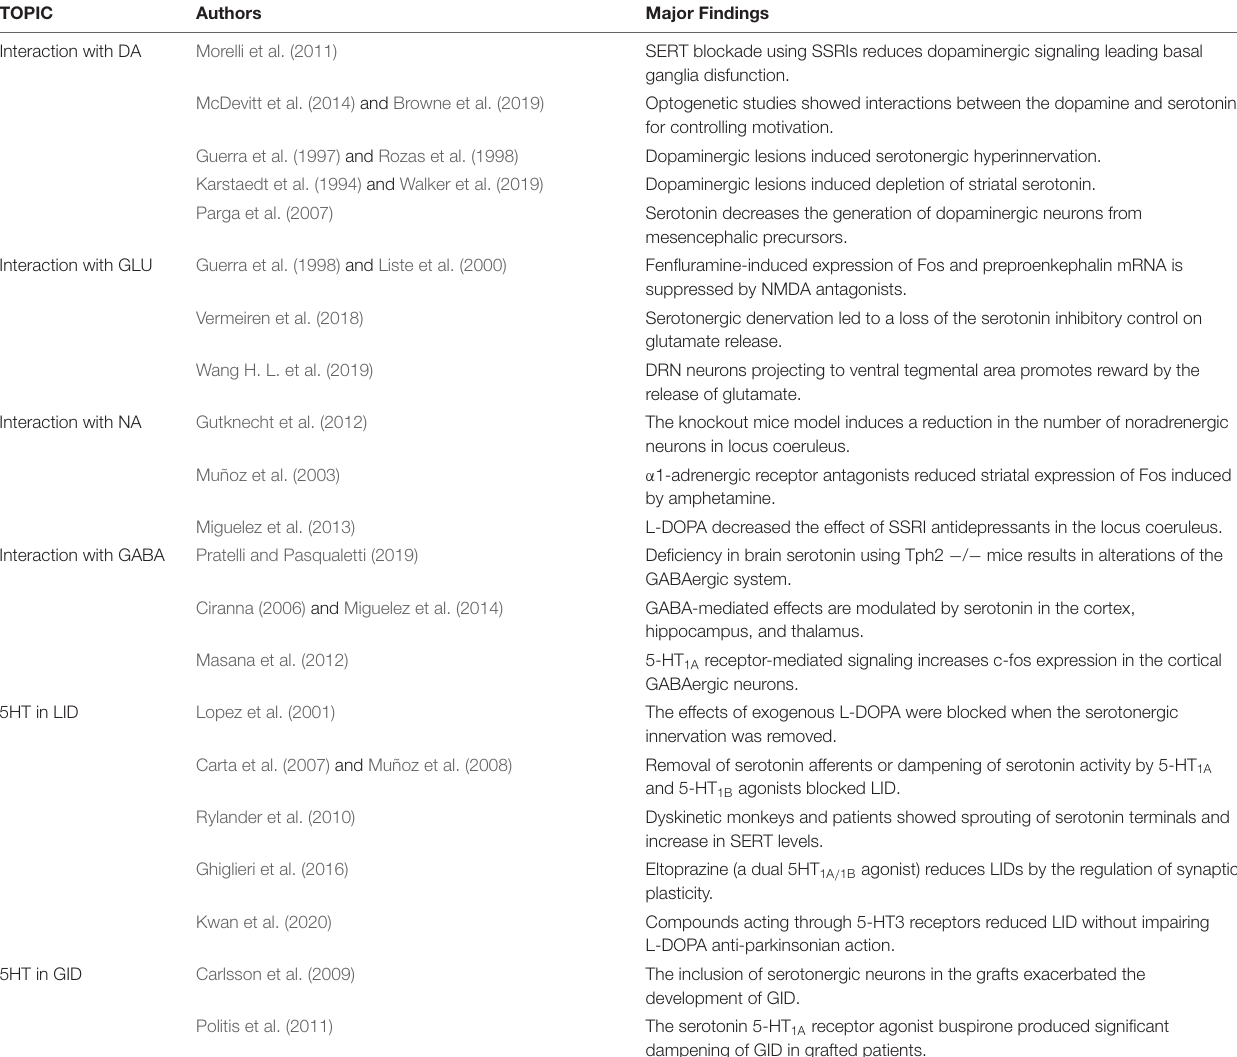
TABLE 1 | Summary reporting the major findings obtained in the different topics. TOPIC Authors Major